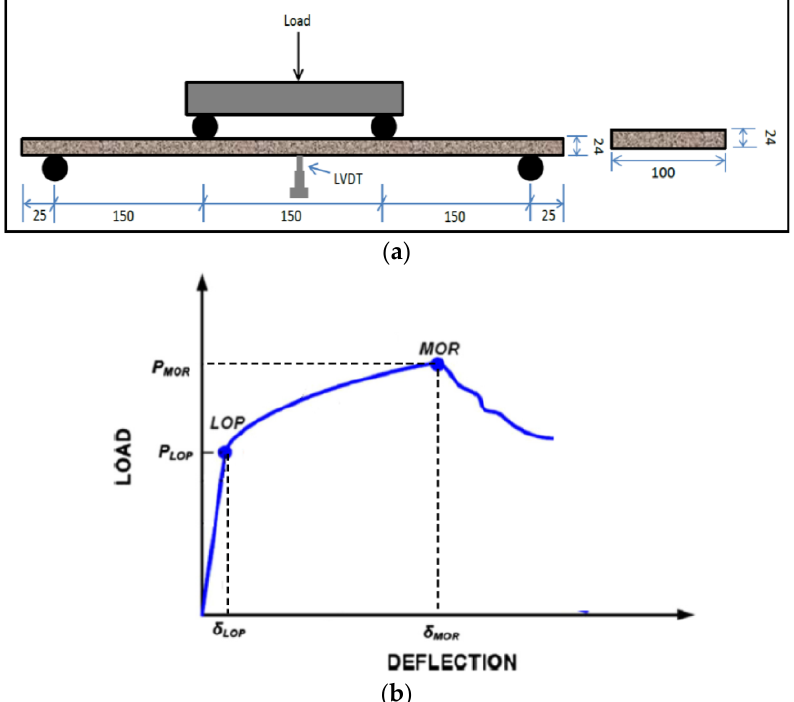
Figure 3. ( a ) Sample details and loading arrangement for the flexural strength test (measurements are in “mm”). ( b ) Load versus deflection curve (Typical) .